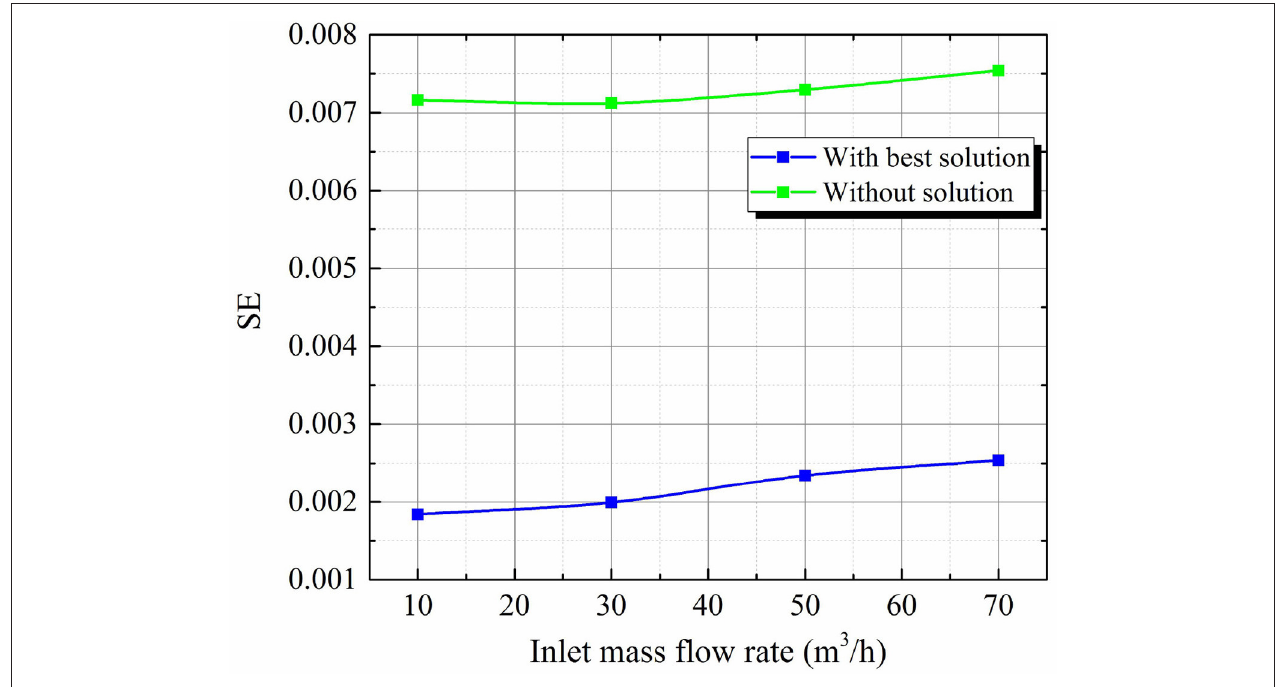
FIGURE 11 | The effect of inlet mass flow rate on the insert